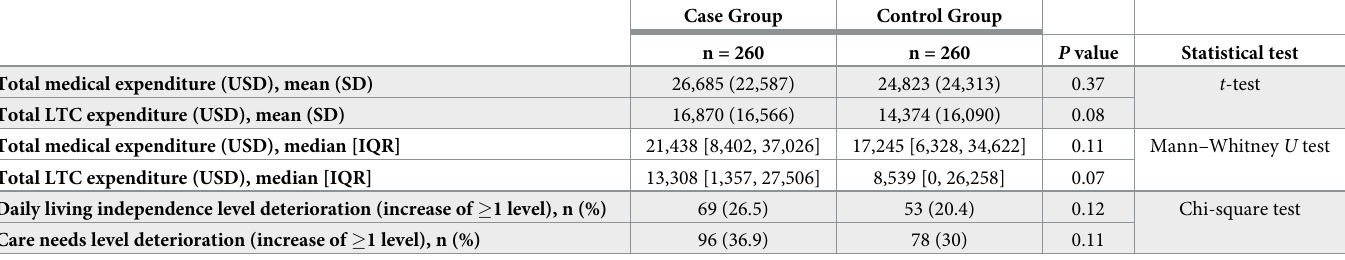
Table 2. Univariable analyses of outcomes between the PS-matched case and control